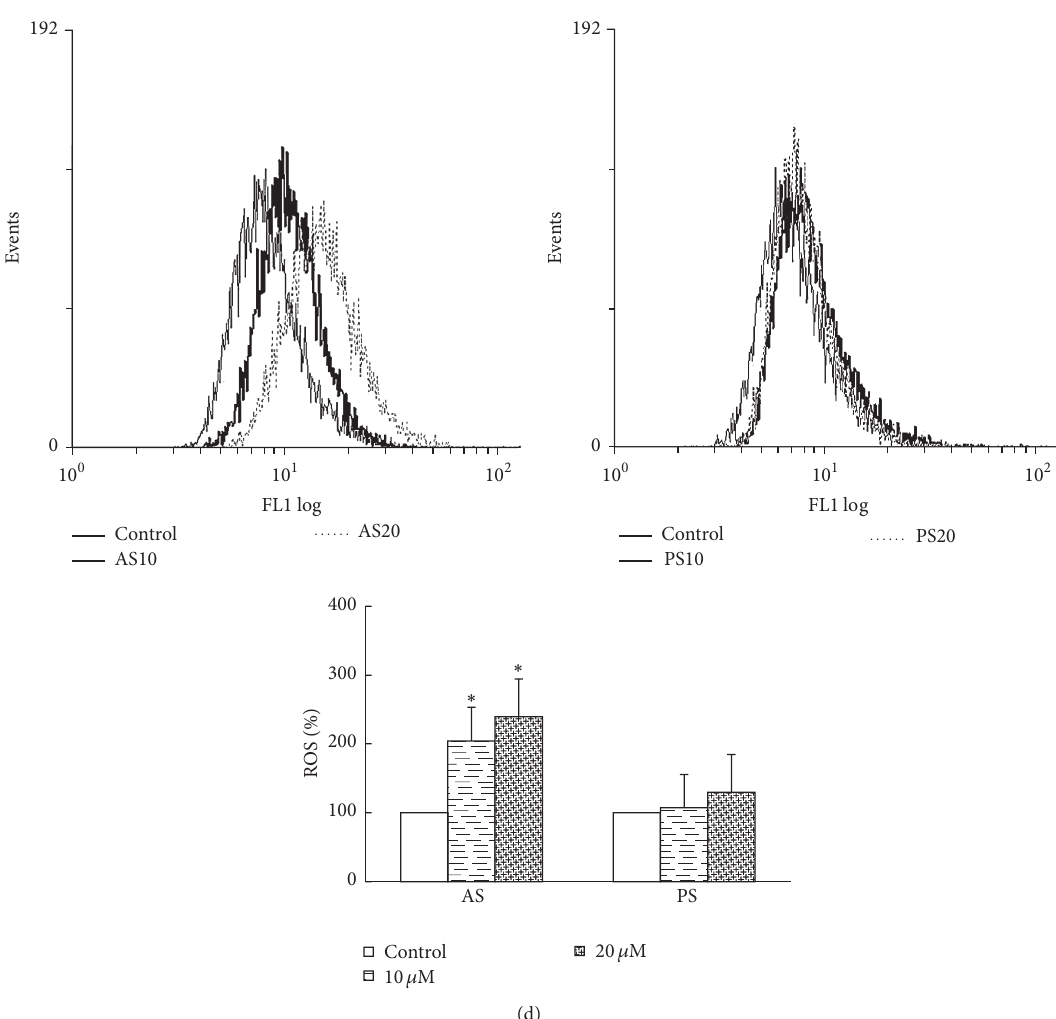
Figure 2: Treatment of AS in ROS-induced necrotic cell death. (a) The sub-G1 cell fractions were significantly dose-dependent and increased after exposure to AS; PS did not change cell cycle parameters. (b) Lower-left quadrants: viable cells. Lower-right quadrants: early apoptosis. Upper-left quadrants: necrotic cells. Upper-right quadrants: nonviable late apoptotic cells. An increased necrotic proportion of NIT-1 cells (Annexin V − PI + cells) was observed after treatment with AS; no effect was observed in PS-treated cells. (c) IL-6 is a highly reliable marker of necrosis. IL-6 secretions in NIT-1 cells treated with AS; no IL-6 secretion was observed in PS-treated cells. The value for the CON group